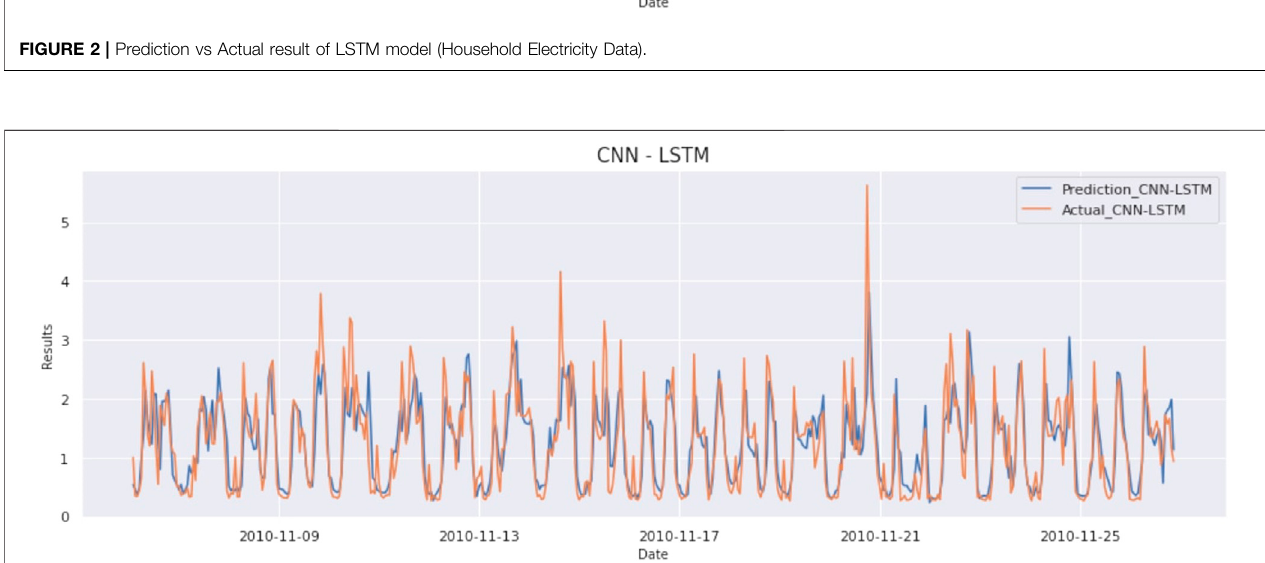
FIGURE 3 | Prediction vs Actual result of CNN-LSTM model (Household Electricity Data).